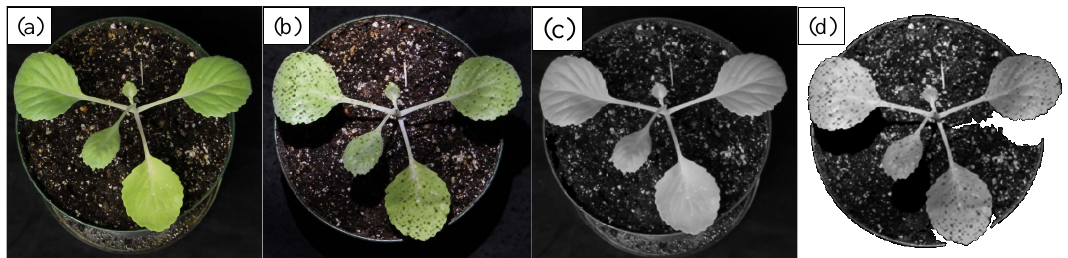
Figure 4. Segmentation of a cabbage plant and its soil from the background. The plant ( a ) without and ( b ) with using structured light; segmentation results of ( c ) without and ( d ) with using structured light; note that (c,d) are the results of binary segmentation in which the plant and its soil are necessarily isolated from the black background; and (c) indicates segmentation